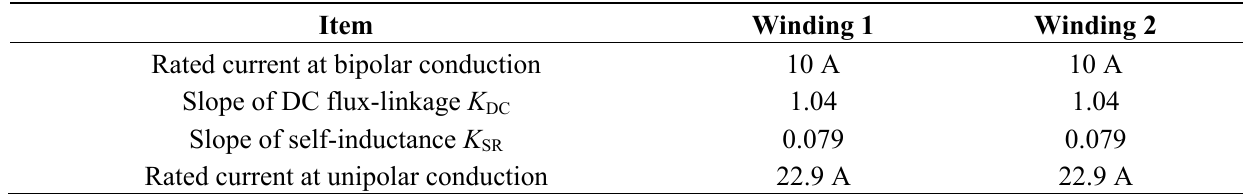
Table 3. Key parameters at different conduction